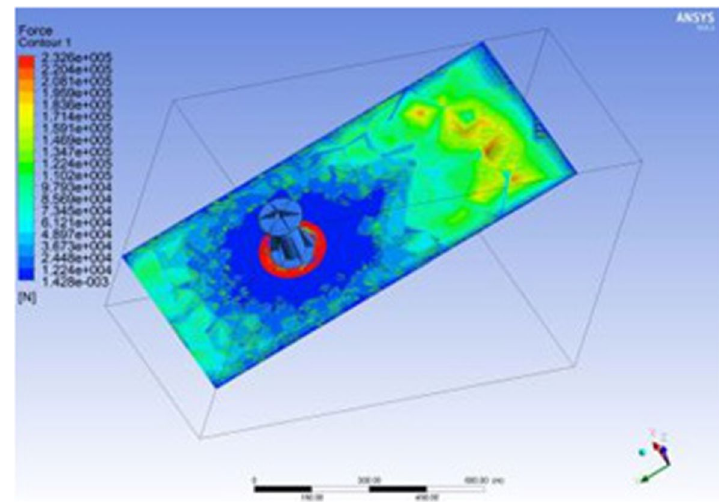
Fig. 13 Distribution of force in the XOY plane of a wind speed of 10 m/s and a wind direction of 30° (Vasilescu